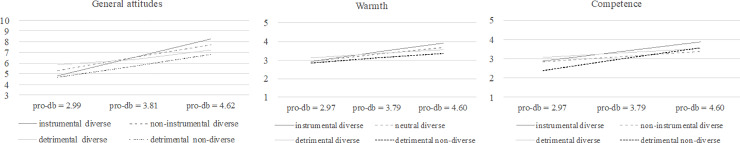
Effects of pro-diversity beliefs and instrumentality on general attitudes, warmth, and competence in Study 1.pro-db = pro-diversity beliefs.